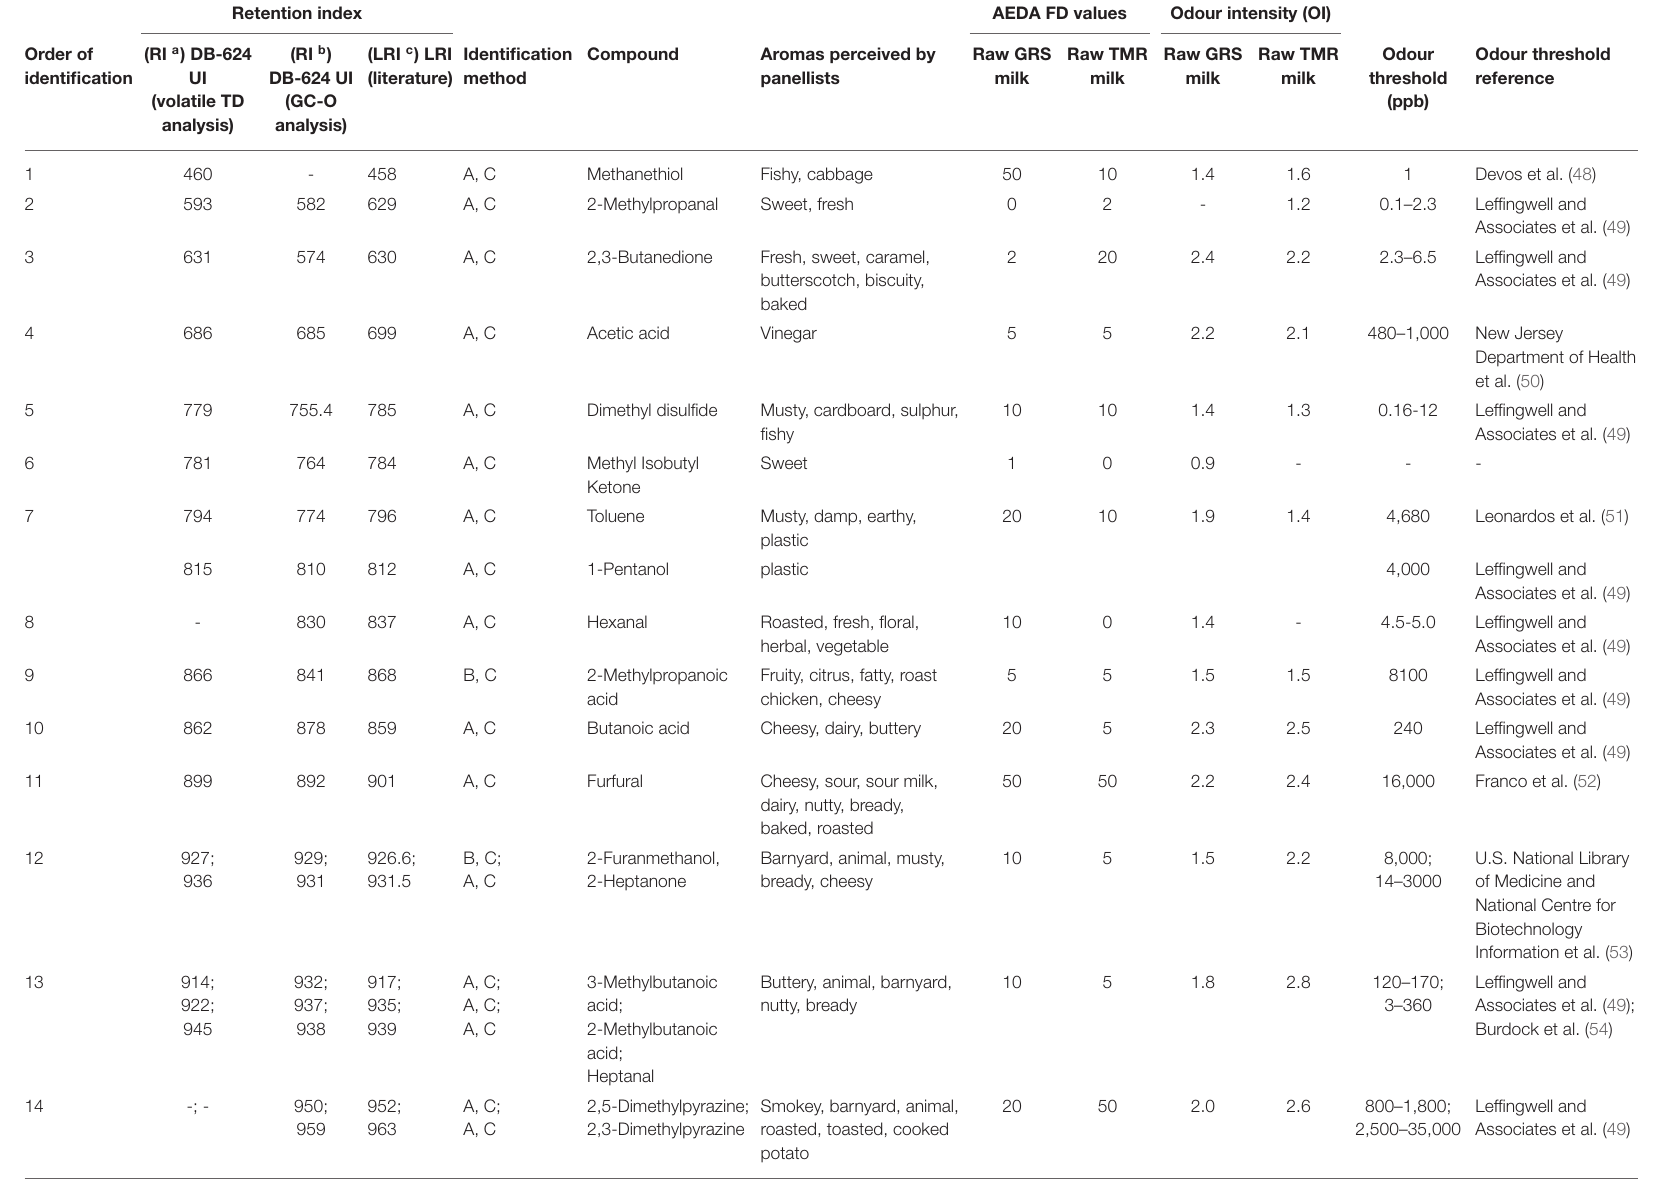
TABLE 3 | Aroma-active compounds perceived in raw bovine milk from cows-fed grass (GRS) or TMR by gas-chromatography olfactometry (GC-O).